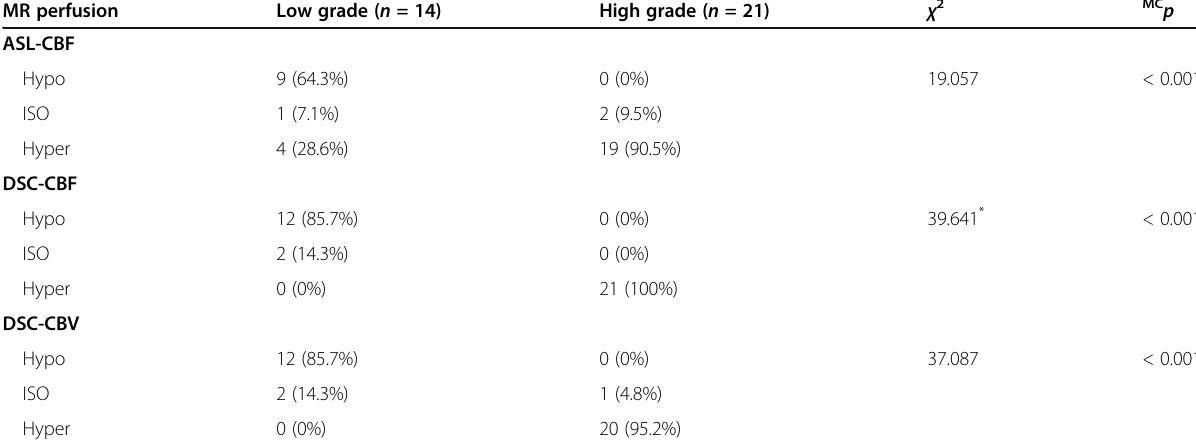
Table 4 Comparison between the two studied groups according to different MRI perfusion parameters MR perfusion Low grade ( n = 14)